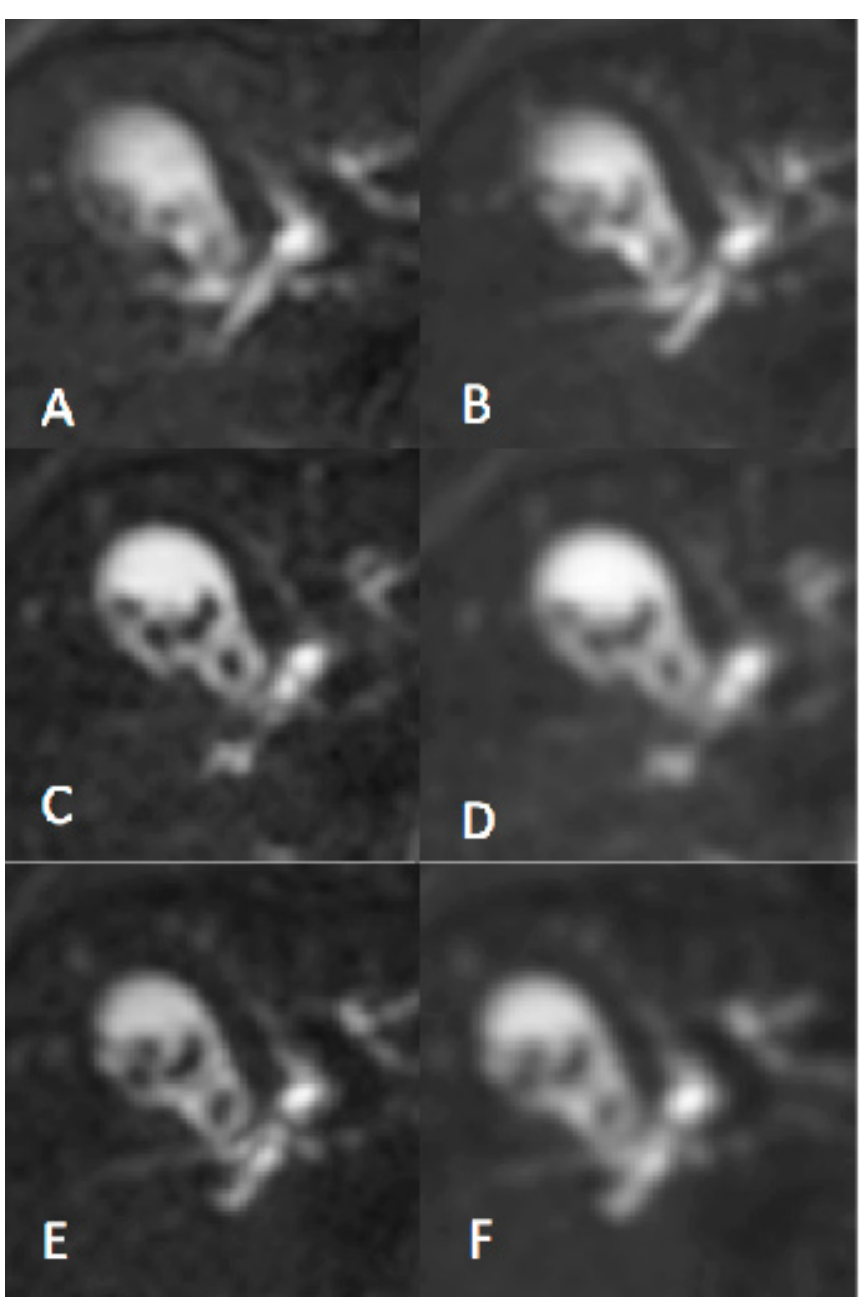
Fig 3. Average image slices with and without motion correction. DW-MR image data showing the gallbladder containing gallstones illustrating the differences in image sharpening with different methods (v3- 0528-slc24); selected average image slices (b-value = 100 s / mm 2 ); protocol A (A) and NRA method (B); simple averaging AVG (C) and the corresponding blurred version AVG-b (D); LRA method (E) and the corresponding blurred version LRA-b (F); for blurred images one pixel Gaussian blurring were applied; gamma adjusted.